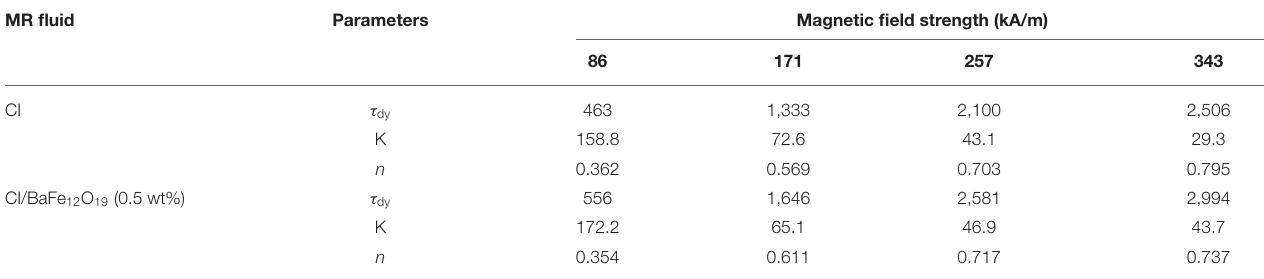
TABLE 1 | The optimal parameters in Herschel–Bulkley (HB) model equation obtained from shear stress